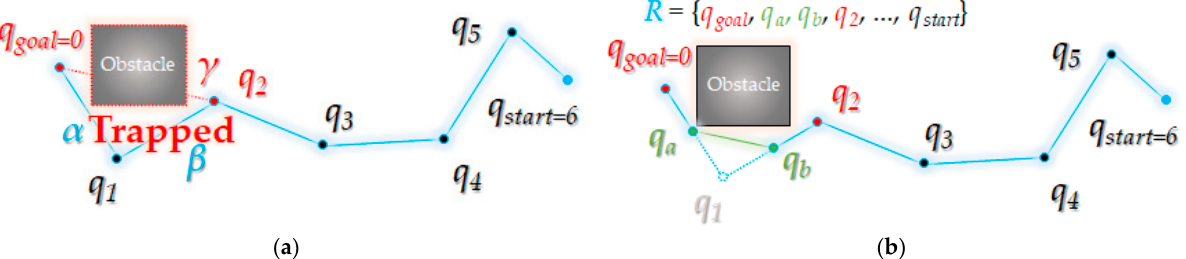
Figure 3. Summary of post triangular processing of the midpoint interpolation method: ( a ) line segment γ with node q 0 and its grandparent node q 2 in tree R is not free from obstacle collision; ( b ) Parent node q 1 of q 0 is deleted, and q a between q 0 and q 1 , and q b between q 1 and q 2 are inserted as waypoints of a new path between q 0 and q 2 .